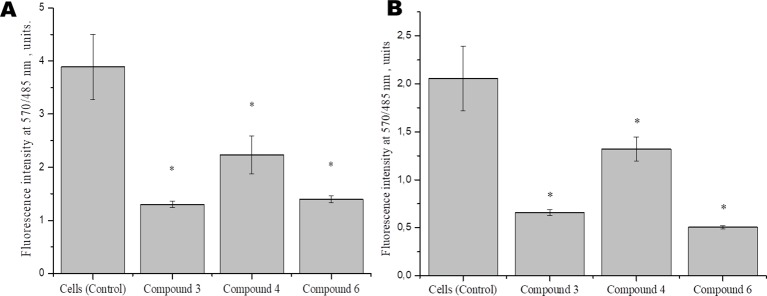
Effects of DNICs on the mitochondrial membrane potential of fibroblasts (cell line HLEF-104) (A) and rat cardiomyocytes (cell line H9c2) (B). Cells were treated with DNICs (2 × 10-4 M) or without (control) for 15 min, then JC-1 was added. The ratio of red fluorescence (mitochondrial JC-1) to green fluorescence (cytoplasmic JC-1) was used to calculate the mitochondrial potential. *P ≤ 0.05 vs. control group. The values presented are the means ± SD of four independent experiments, n = 4.